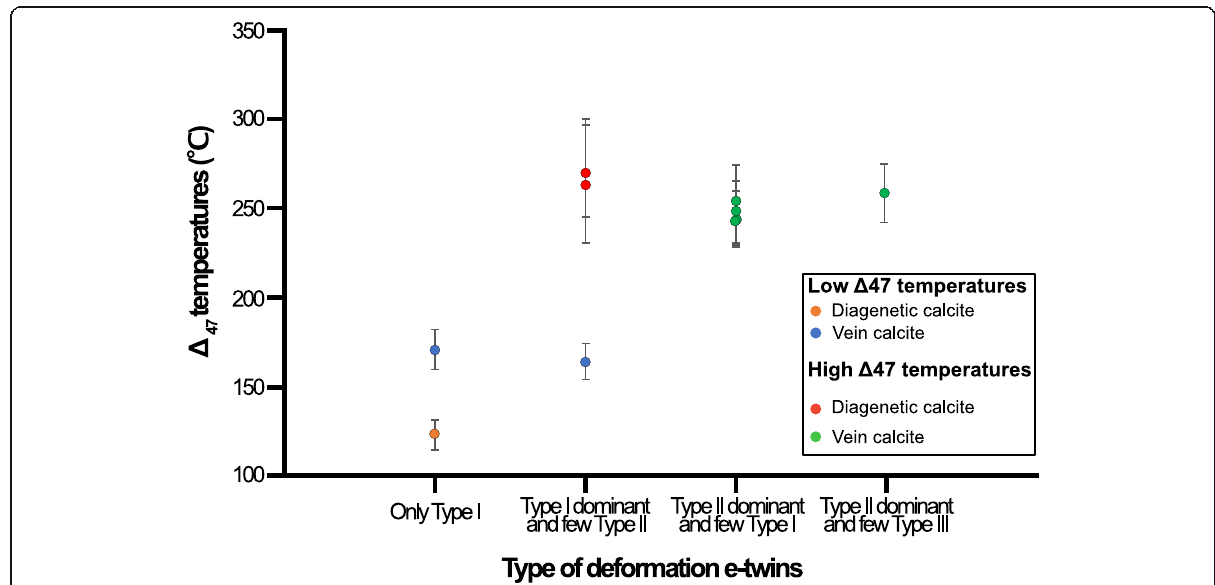
Fig. 6 Scatter plot showing calcite deformation e-twin morphologies against Δ 47 temperatures. The deformation twin types based on e-twin morphologies (Ferrill et al. 2004) are presented for each sample (Table 1). Clumped isotope data of the corresponding samples are plotted from SET 1 and SET 2-1 (Table 1) excluding any repetitive data to reduce overlap (see Supplementary Table 3S for details). The error bars indicate the range of clumped isotope temperatures for each sample. High temperature vein calcite and diagenetic calcite show considerable overlapping of the error